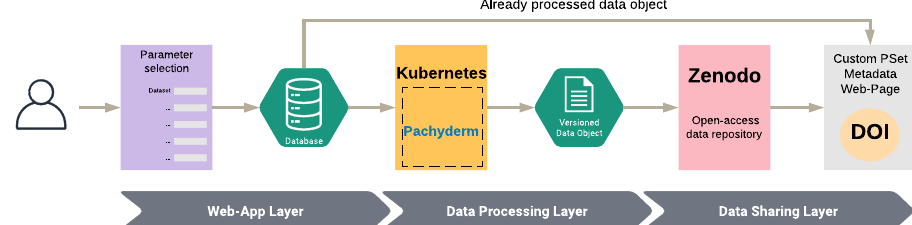
Fig. 3 The ORCESTRA framework layers for pipeline selection, data-object generation, and digital object identi fi er (DOI) sharing with a custom metadata web page. The web-application layer allows users to request custom data objects, which are generated through Pachyderm in a Kubernetes cluster within the data-processing layer. Each versioned data object is automatically pushed to the data-sharing layer and uploaded to Zenodo to obtain a DOI. Data objects that have already been processed result in the immediate sharing of custom metadata web pages with users via